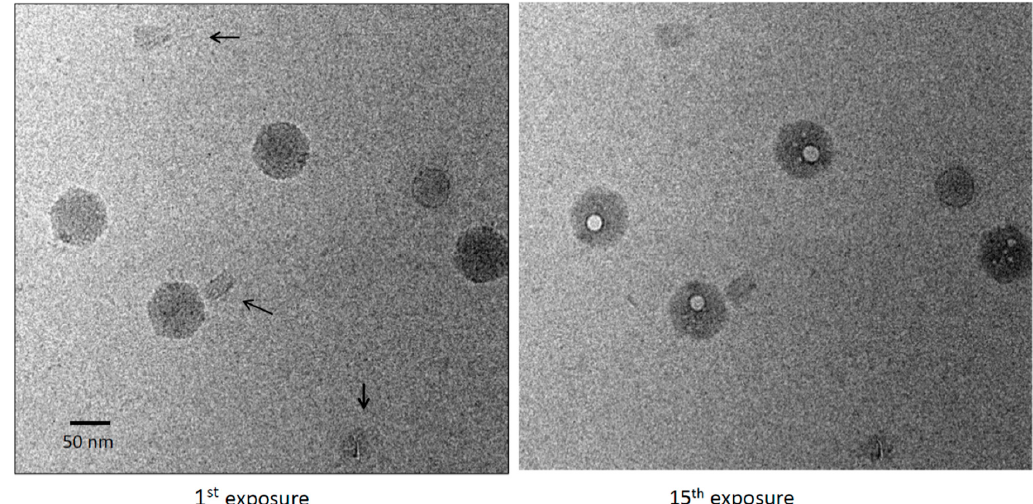
Figure 2. First and 15th exposures from a dose series of a mixture of DNA origami and bacteriophage P22. Origami are marked with black arrows in the left-hand panel. The virions show large primary bubbles (right-hand panel), plus a few small secondary bubbles, whereas the origami have no bubbles.